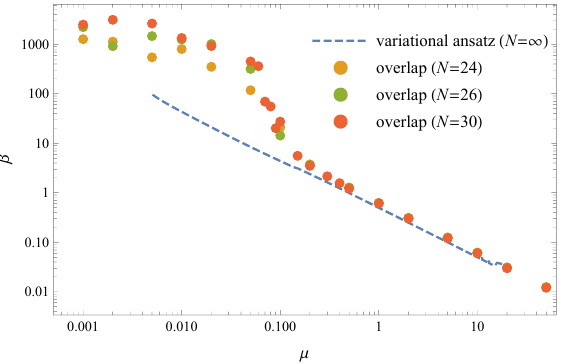
Figure 13 . The maximized overlap viewed in axis (cid:22) .